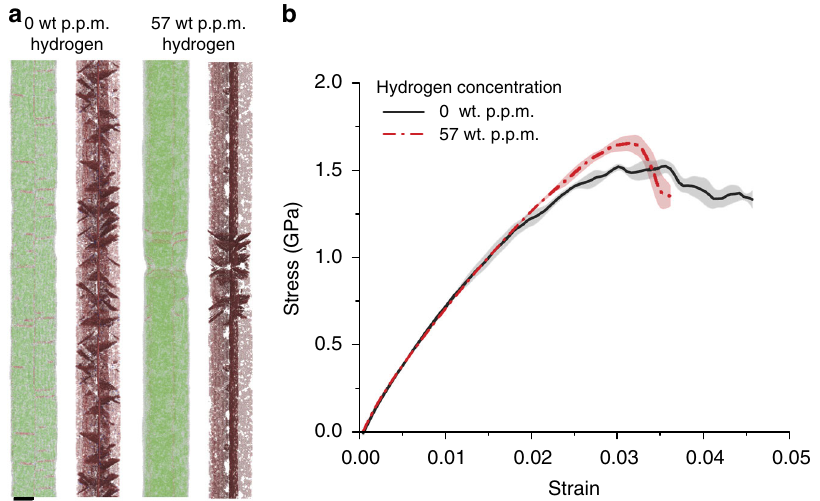
Fig. 2 MD simulation of tensile testing of penta-twinned Ag NWs. a Simulated transition from distributed plasticity in the absence of hydrogen to localized plasticity in the presence of hydrogen. Scale bar, 7 nm. b Averaged stress – strain curves of Ag NWs at different hydrogen concentrations with SE bars. Black line corresponds to 0 wt p.p.m. of hydrogen and red dashed line correspond to 57 wt p.p.m. of